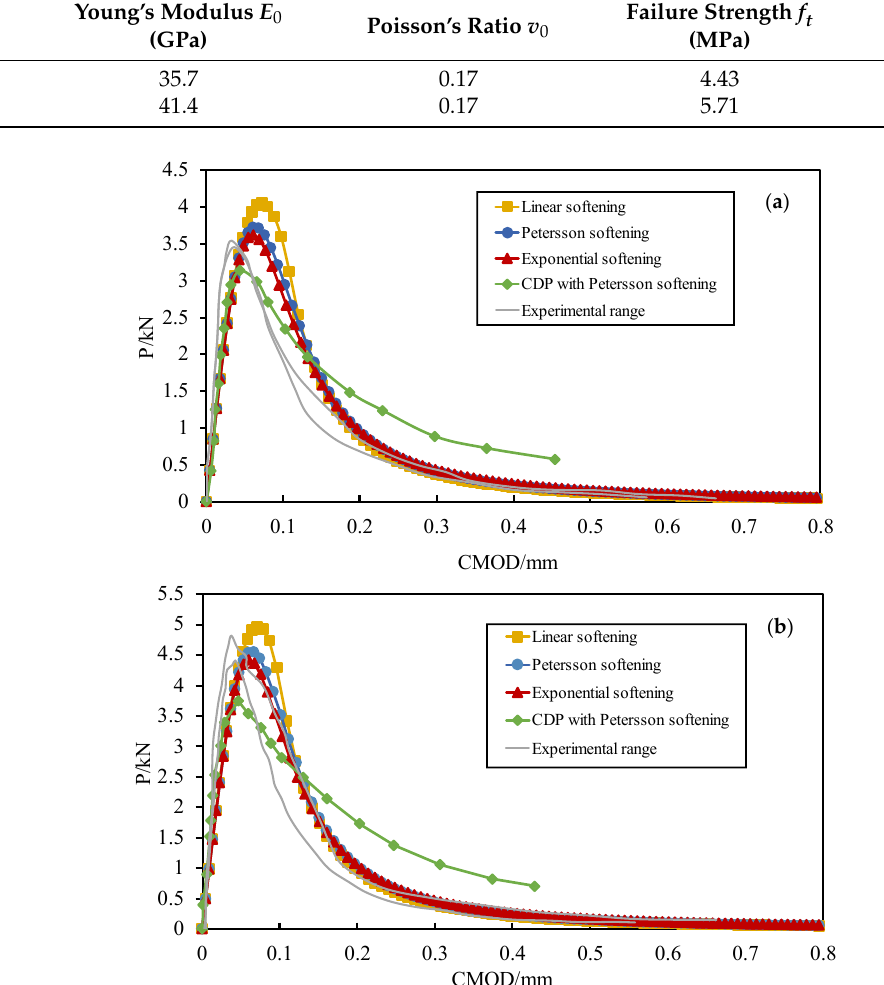
Figure 4. P-CMOD curves obtained from exponential, linear and Petersson’s softening laws using the PF-CZM, the concrete damage plasticity (CDP) model with Petersson’s softening law and the experimental results [43] of ( a ) C60 concrete and ( b ) C100 concrete.